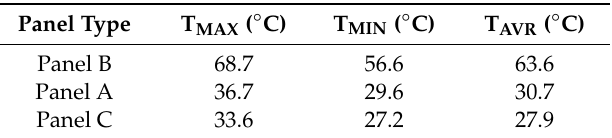
Table 2. Temperatures read in the measurement fields of the thermogram made for the mobile stand. The thermograms were obtained in weather conditions close to windless conditions, with a low average wind speed of up to 1.6 m / s. The maximum recorded values of solar radiation intensity were within the range of 716.7 W / m 2 –738.4 W / m 2